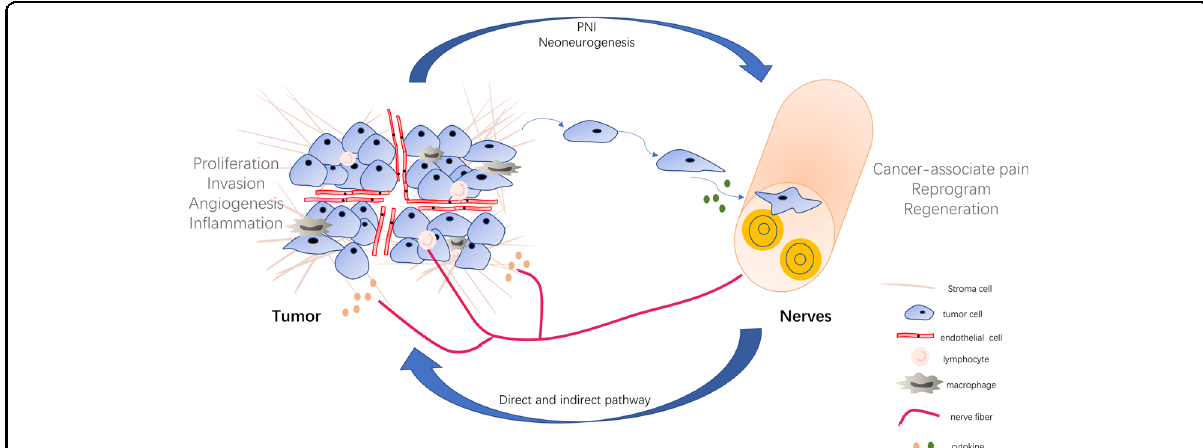
Fig. 1 The nerve – tumor crosstalk. Nerves can secrete the neuroactive molecules that act on tumor cells, lymphocytes, and macrophages to promote tumor proliferation, invasion, angiogenesis, and in fl ammation. In turn, tumor cells migrate to nerves and damage them to induce the cancer-associated pain. Moreover, tumor cells secrete cytokines, which drive nerve reprogramming and regeneration. PNI perineural